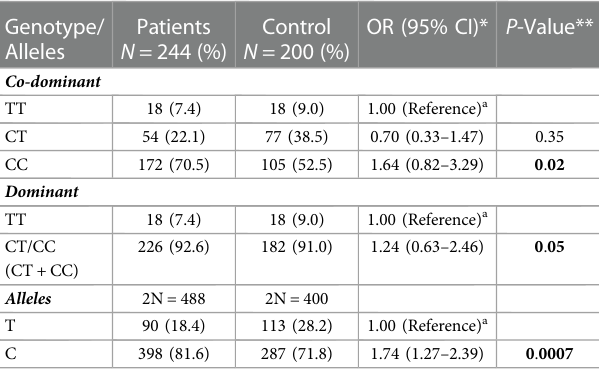
TABLE 2 Frequency of IL4 gene -C590T polymorphism genotypes and alleles in Kuwaiti T1DM patients and controls. Genotype/ Patients Alleles N = 244 (%)